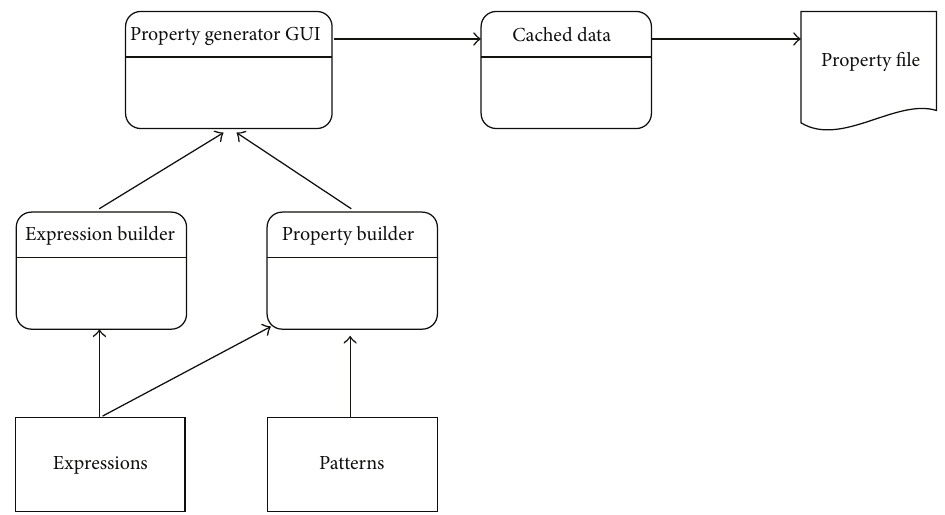
Figure 8: Main components of the Property Generator